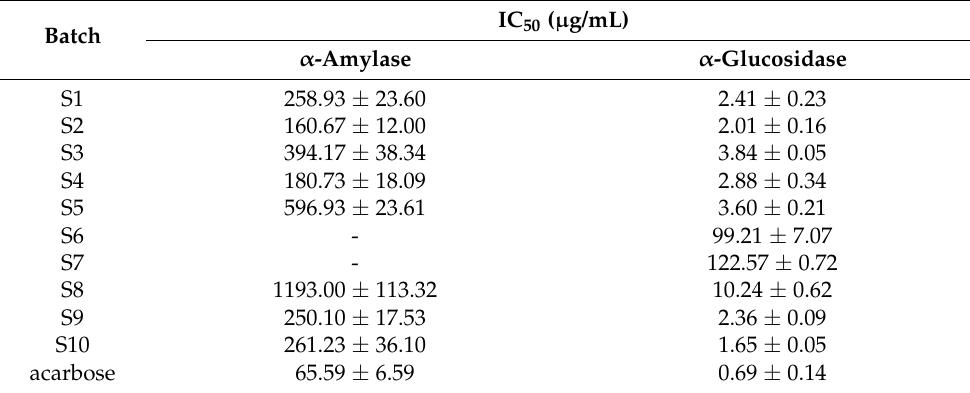
Table 3. Inhibition of α -amylase and α